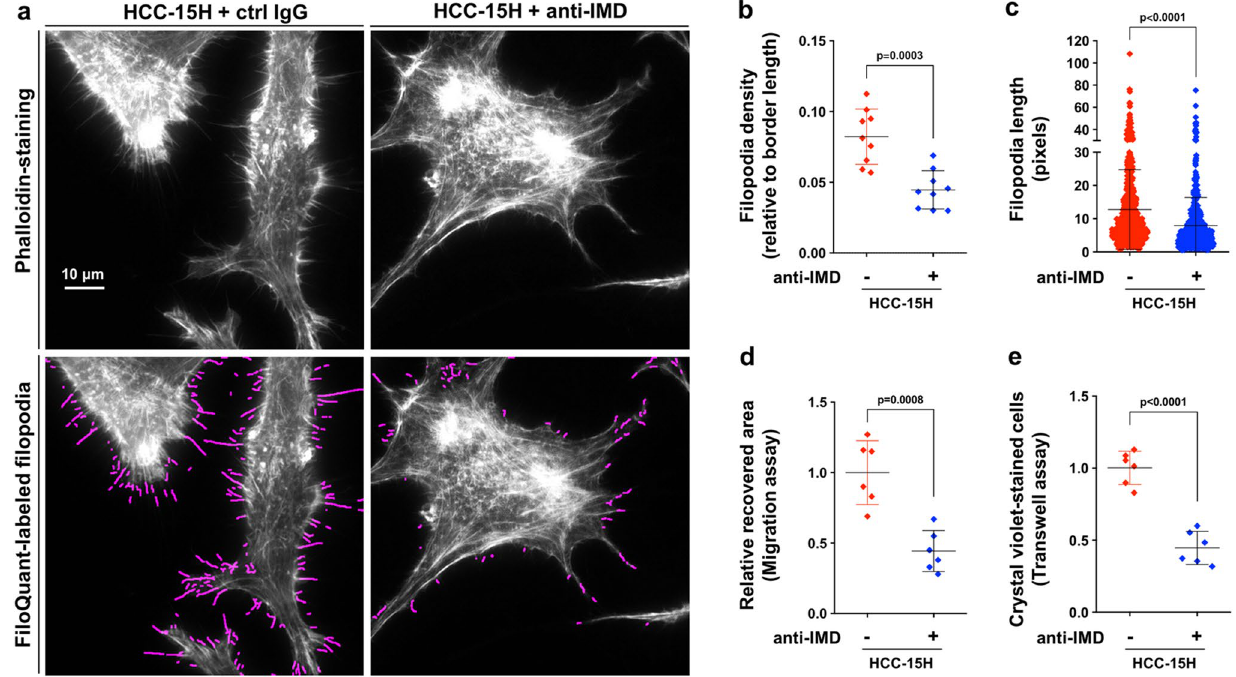
Figure 4. Anti-IMD inhibited the formation of filopodia and invasive ability of HCC cells. ( a ) HCC-15H cells treated with or without anti-IMD were stained with AlexaFluo568-phalloidin and analyzed using FiloQuant. ( b , c ) The filopodia density and length were measured using 10 randomly chosen fields. ( d , e ) The cell migration and invasion ability were measured using Wound healing assay and Transwell assay (n = 6). All data were presented as scatter plots with mean ± SD. Significance was assessed by unpaired t test with Welch’s correction ( b , d , e ) or Mann–Whitney u test ( c